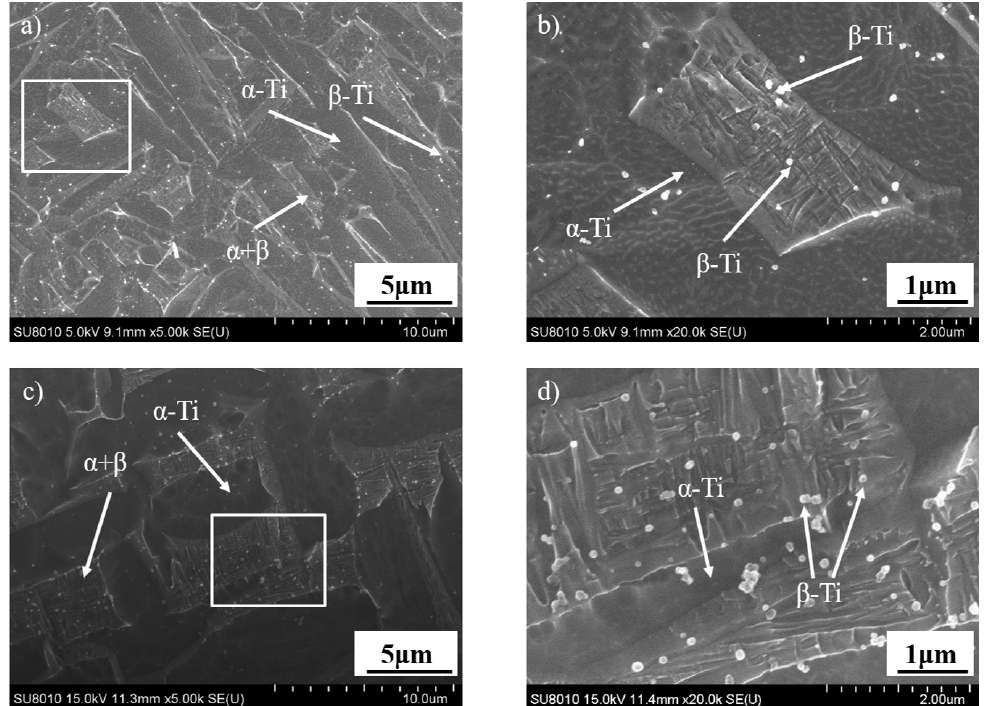
Figure 7. SEM images of normalizing at di ff erent temperatures in the α + β phase zone. ( a ) 930 ◦ C / 2 h / AC, ( b ) enlarged view of the box in Figure 7a, ( c ) 990 ◦ C / 2 h / AC, ( d ) enlarged view of the box in Figure